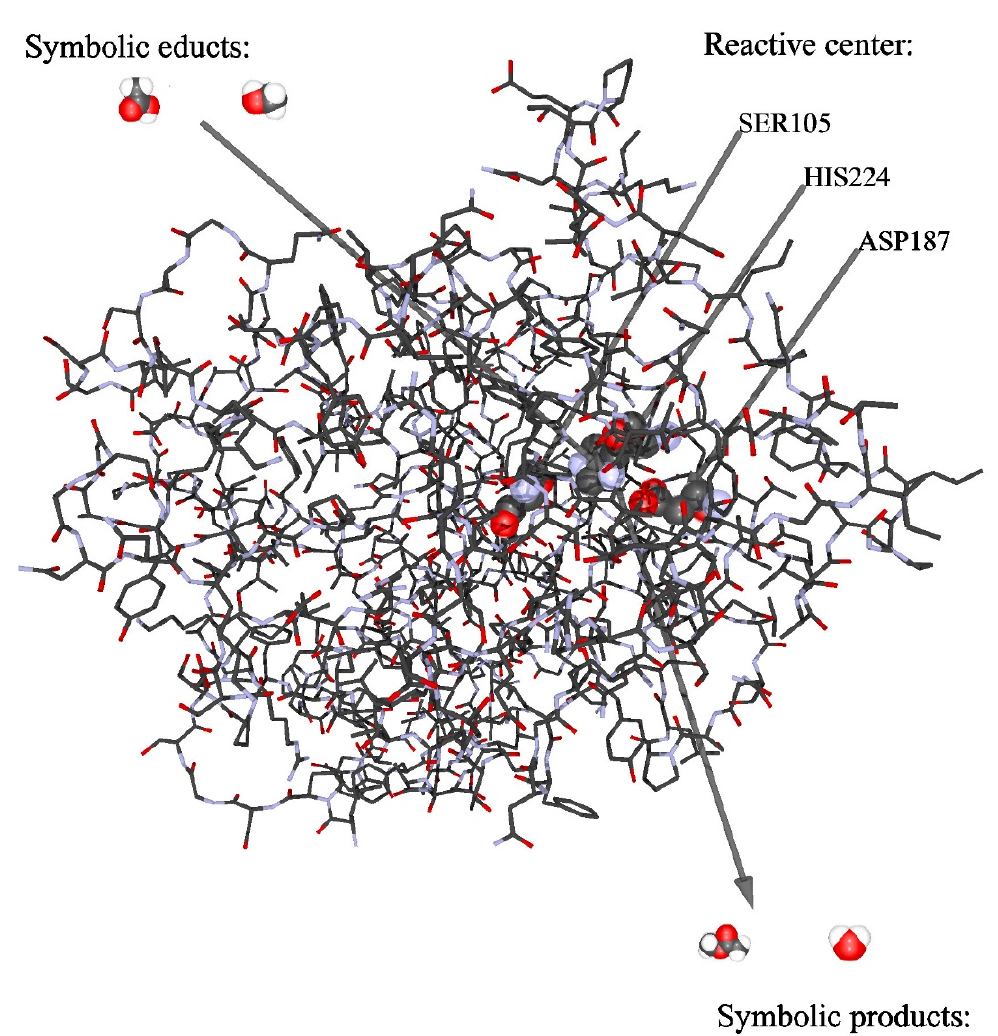
Figure 1. Schematic view on the active site of the enzyme Candida antarctica Lipase B. Illustration obtained with data given in [34] and program Rasmol (www.OpenRasMol.org, accessed on 15 January 2021).